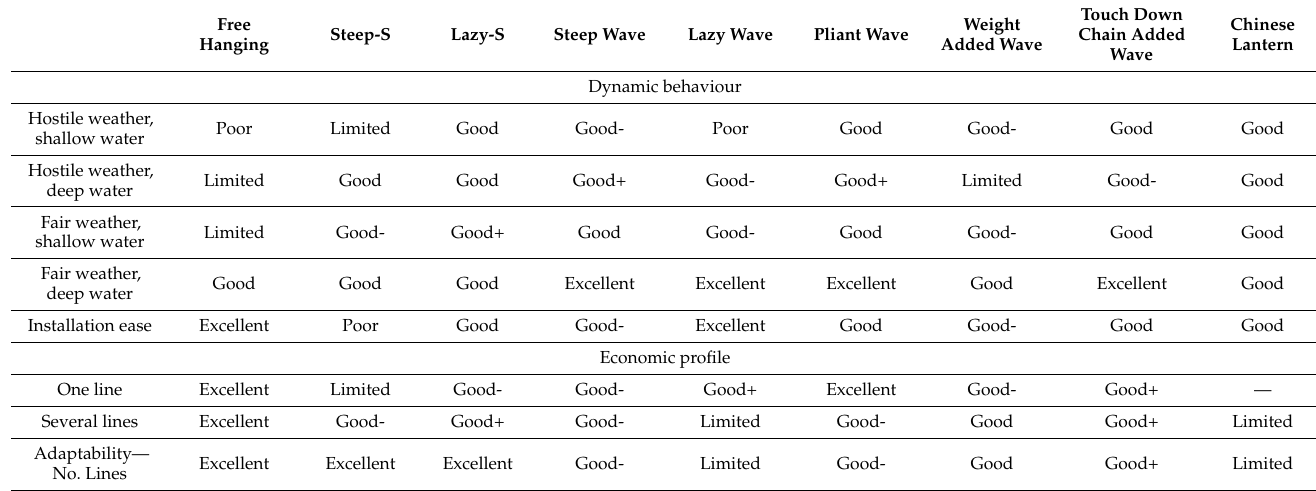
Table 8. Riser Configuration Selection Matrix, (adapted from IKM Ocean Design in-house data). Free Hanging Steep-S Lazy-S Steep Wave Lazy Wave Pliant Wave